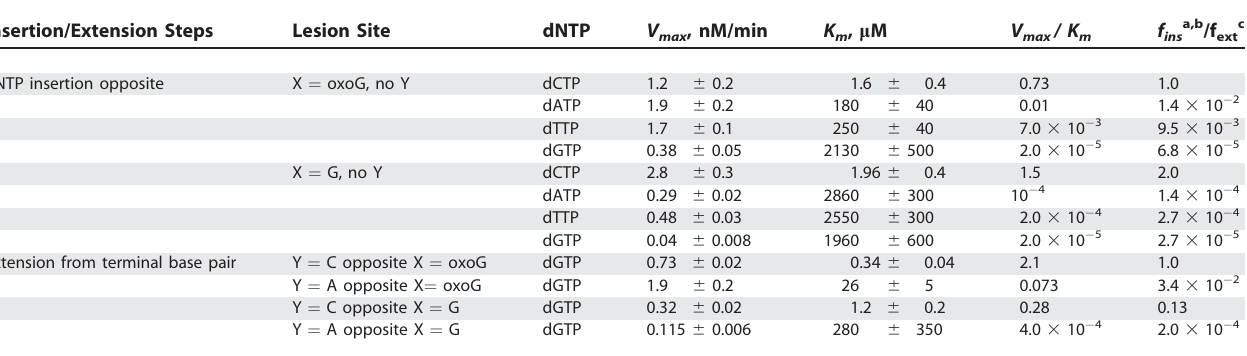
Table 1. Kinetic Parameters of Insertion and Extension Catalyzed by Dpo4 Insertion/Extension